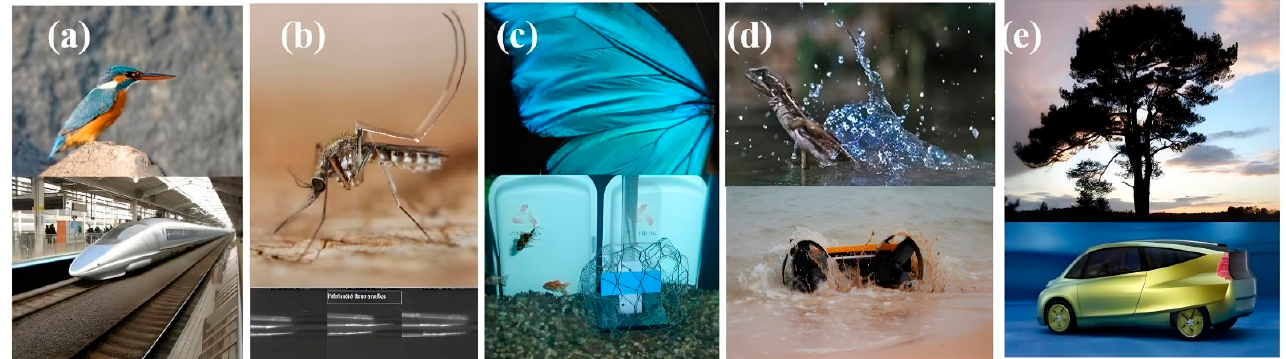
Figure 5. Application of bionics product design in the engineering field: ( a ) the bionic kingfisher beak train head, (https://mp.weixin.qq.com/s/1qN4fwEtKdzyd2J67EZ_2A (accessed on 26 July 2016)) ( b ) the zig ‐ toothed tip of a bionic mosquito mouthpiece (http://www.si ‐